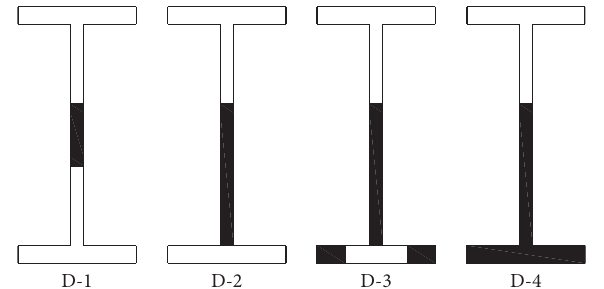
Figure 16: Damage cases of the I-40 bridge.